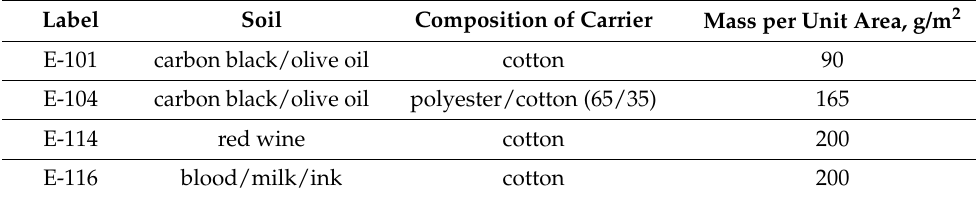
Table 2. EMPA stain donors—standard stained fabrics (E-101, E-104, E-114 and